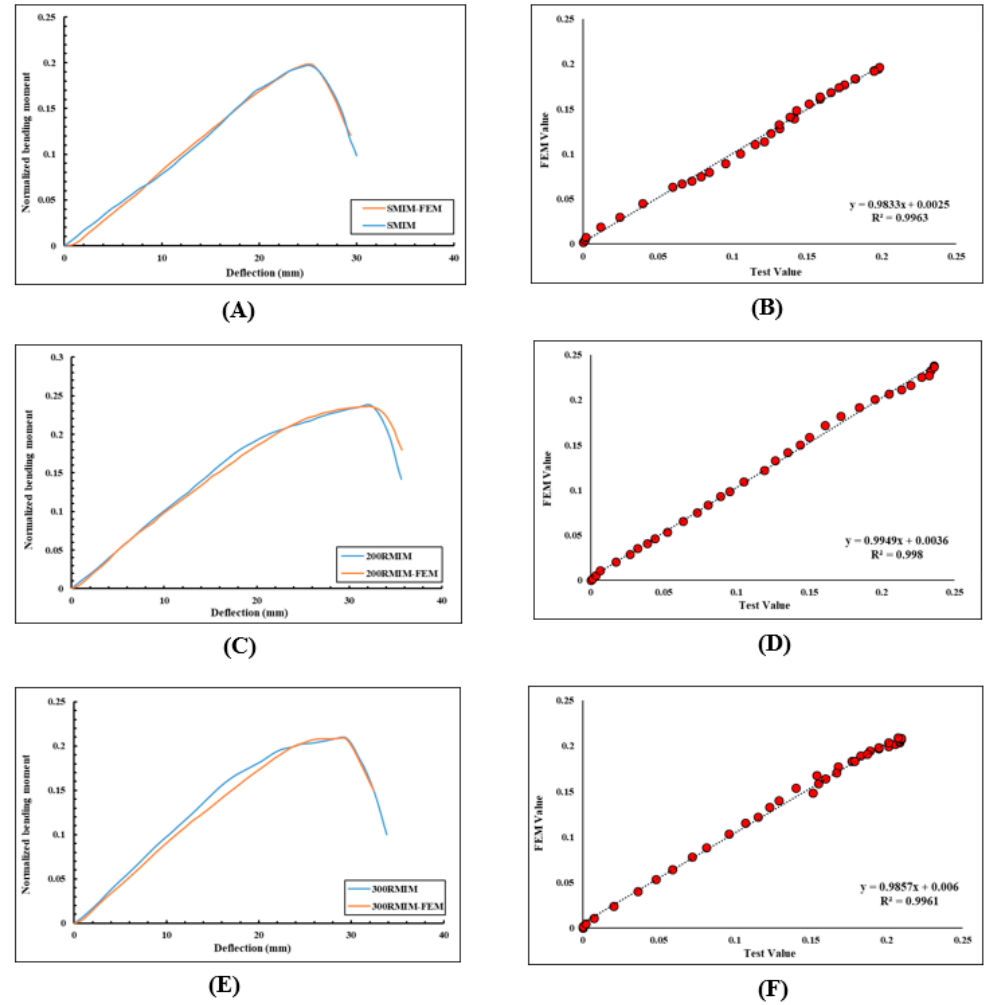
Figure 26. Comparison of finite element model against minor axis test results along with the linear regression: ( A ) and ( B ) non-reinforced model; ( C ) and ( D ) 200 mm reinforced model; ( E ) and ( F ) 300 mm reinforced model. Table 5. Finite element model vs experimental results accuracy details in terms of evaluation criteria.